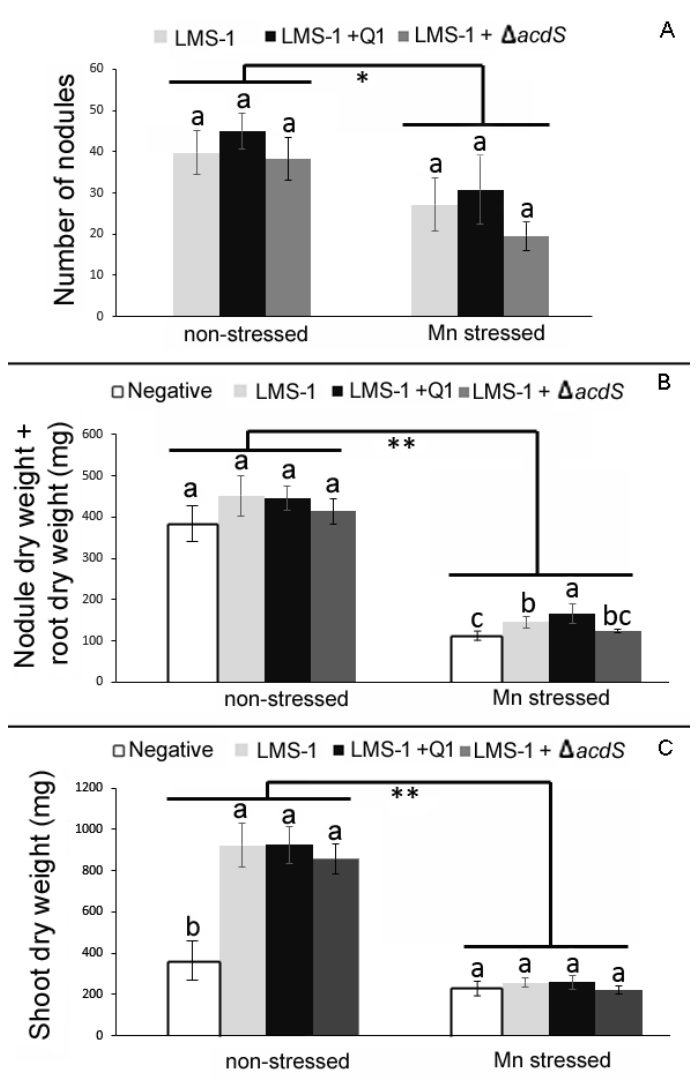
Figure 3. E ff ects of single inoculation ( M. ciceri LMS-1 (LMS-1)) and co-inoculation ( M. ciceri LMS-1 and Pseudomonas sp. Q1 (LMS-1 + Q1) or M. ciceri LMS-1 and Pseudomonas sp. Q1 ∆ acdS mutant (LMS-1 + ∆ acdS )) on chickpea plants grown in a vermiculite pot assay for 54 days. ( A ) Number of nodules of plants. ( B ) Nodule plus root dry weight of plants. ( C ) Shoot dry weight of plants. Each point represents the mean and standard error values of five plants per treatment. Di ff erent letters (a–c) correspond to statistically significant di ff erences ( p < 0.05) within each group (non-stressed and Mn stressed). * denotes statistically significant di ff erences between the treatments means in the presence and absence of high Mn concentration (* p < 0.01; ** p <